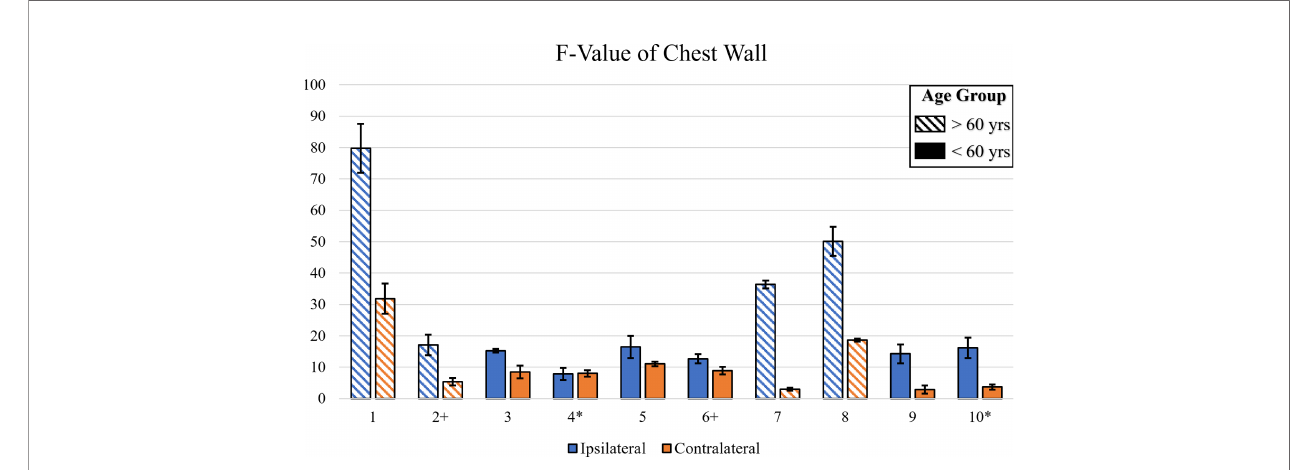
FIGURE 4 | A bar plot illustrating the F-value across all patients for the irradiated chest wall. The F-value was calculated via One-Way ANOVA for each trial. Symbols near patient number indicate dark skin (*) or ≥ 60 years old (+).